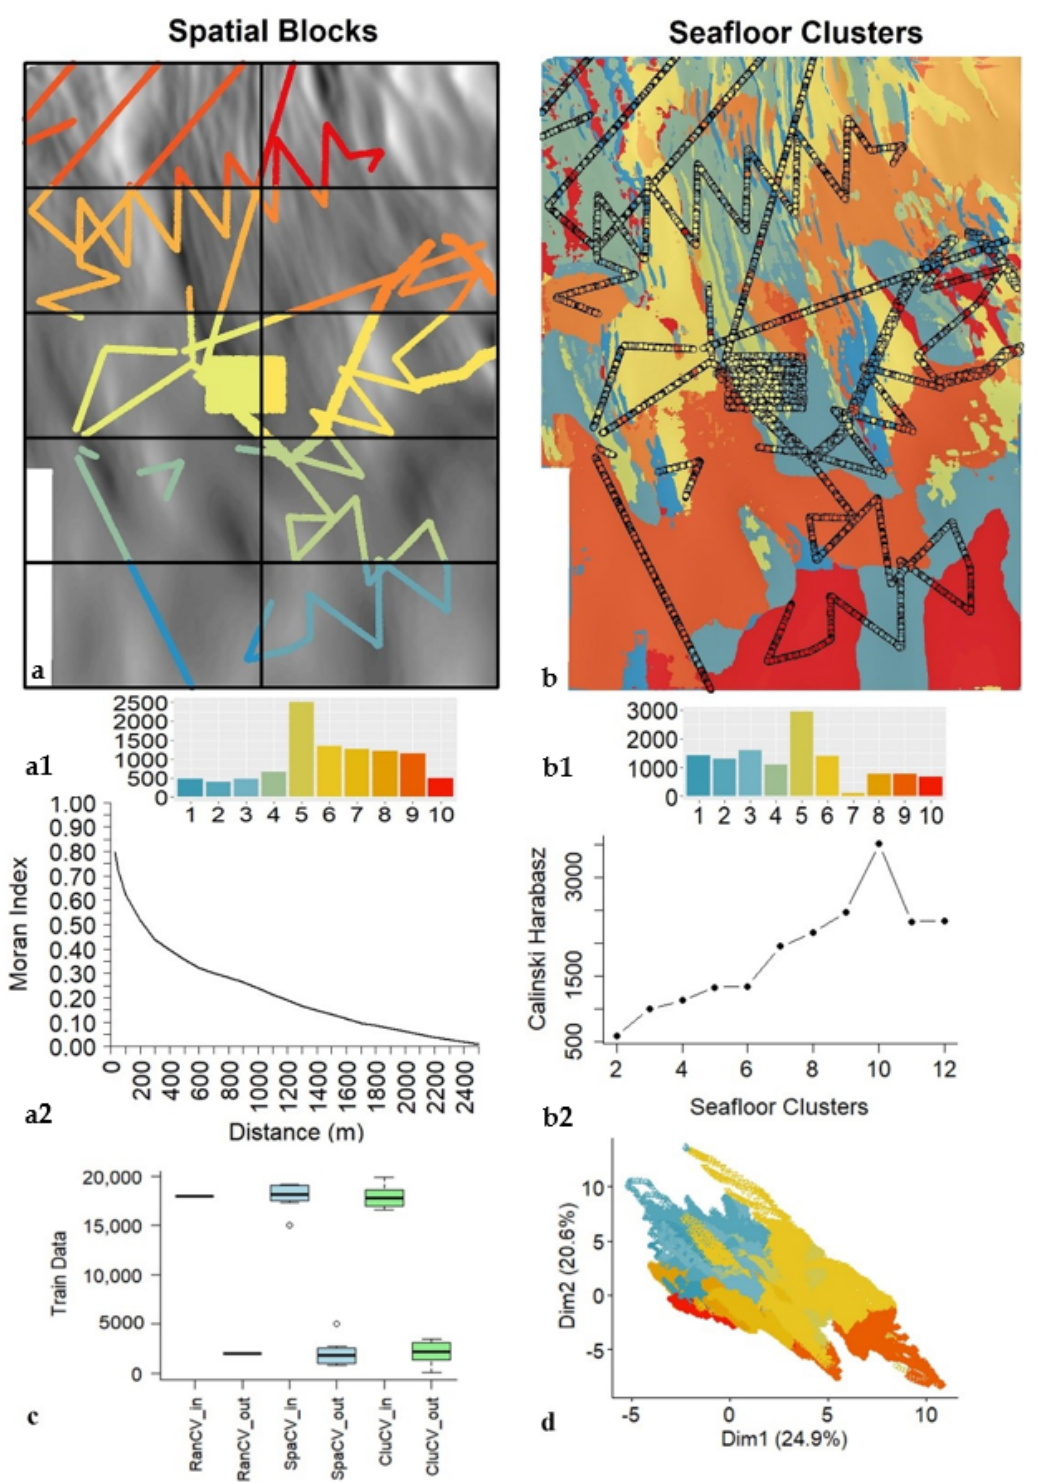
Figure 3. ( a ) Systematic spatial block CV data assignment, consisting of 10 spatial blocks with equally sized sub-areas (2 km × 1 km). The background map is the bathymetric hillshade. ( b ) Seafloor clustering CV consisting of 10 clusters with varying areas between 0.80–3.81 km 2 . ( a1 , b1 ) The sampling effort (here expressed as training points per km 2 inside each spatial/cluster block) is unevenly distributed among the blocks/clusters and within each block/cluster. Noteworthy, the AUV data acquisition did not aim at predictive modeling and was not optimized to achieve a balanced spatial sampling. More samples have been acquired in the central part of the area due to dedicated photomosaic survey [4,9]. ( a2 ) PMN Moran’s I value at varying distances; the Moran’s I still does not reach zero beyond 2 km. ( b2 ) Calinski–Harabasz index score for different numbers of clusters. Ten (10) is the optimum number in CLARA clustering, which is relatively high for